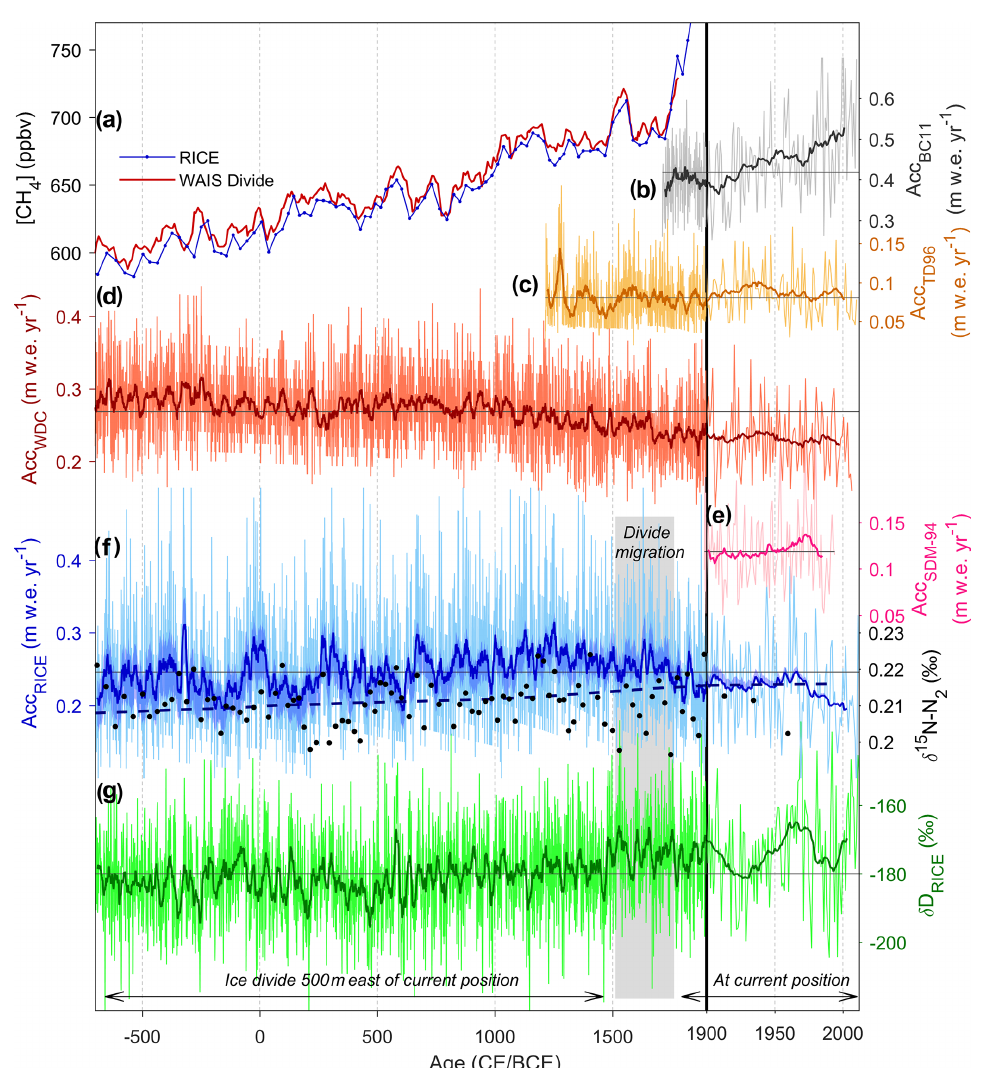
Figure 11. (a) Measured methane concentrations from RICE (blue, on the RICE17 timescale) and from WAIS Divide (red, on the WD2014 timescale). (b) Bryan Coast (BC11, grey), Ellsworth Land (Thomas et al., 2015), (c) Talos Dome (TD96, orange), northern Victoria Land, (Frezzotti et al., 2007; Stenni et al., 2002) (no thinning function applied, extended to 2010CE using stakes measurements), (d) WAIS Divide (WDC, red), central West Antarctica (Fudge et al., 2016) (corrected for ice advection), (e) Siple Dome (SDM-94, pink), Marie Byrd Land (Kaspari et al., 2004), and (f) RICE (blue) accumulation histories over the past 2700 years in annual resolution and 20-year smoothed versions (thick lines). The shaded blue area indicates the 95% confidence interval of the RICE accumulation rates. The short-lived peak in accumulation rates around 320BCE is likely to be an artifact caused by timescale inaccuracies in this period, during which RICE17 diverges from WD2014 (Fig. 9b). Also shown are the gas-derived accumulation rates for this time interval ( f , blue dashed line) and measurements of δ 15 N of N 2 providing information on past firn column thickness ( f , black dots; on the RICE gas timescale). (g) RICE stable water isotope record ( δ D). Thick green line is a 20-year smoothed version of the isotope profile. Grey horizontal lines indicate mean values of the respective accumulation rates and δ D over the displayed period. Note that the scale changes at 1900CE (thick vertical line). The migration period of the Roosevelt Island ice divide is marked with a grey